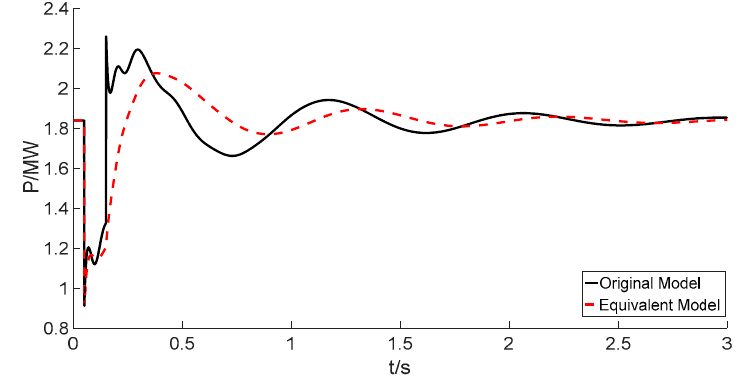
Figure 11. The response of the microgrid under Scenario 1.